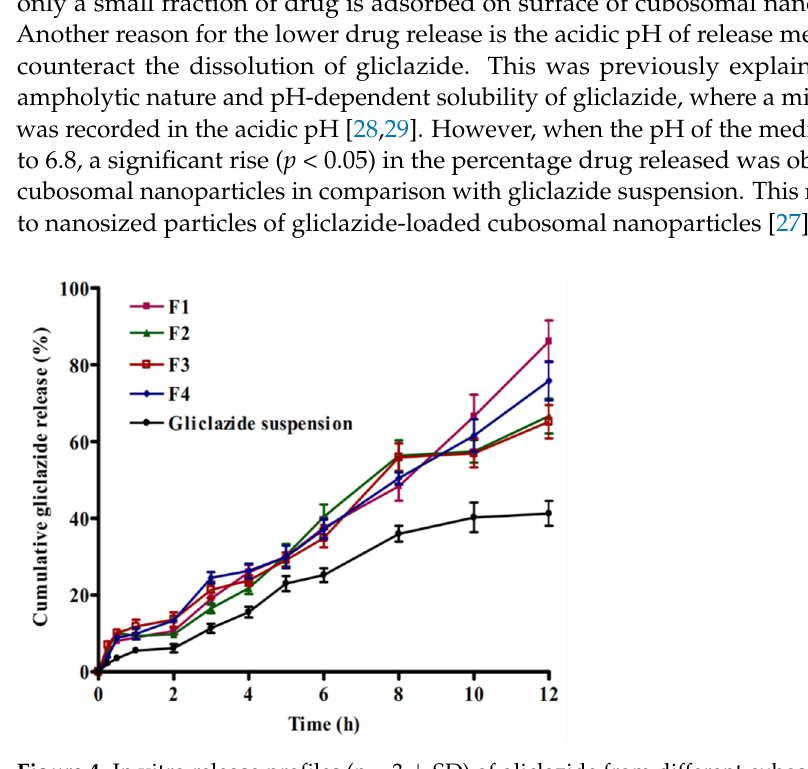
Figure 4. In vitro release profiles (n = 3 ± SD) of gliclazide from different cubosomal nanoparticles formulations (F1–F4) and aqueous gliclazide suspension.